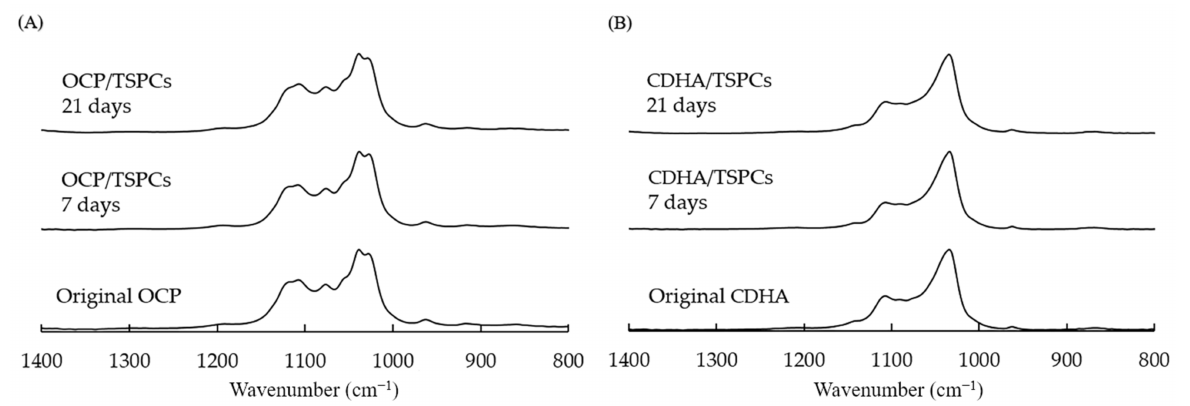
Figure 6. The change in the FTIR spectra of the OCP granules ( A ) or CDHA granules ( B ) before (original) and after immersion in TSPCs culture medium for 7 and 21